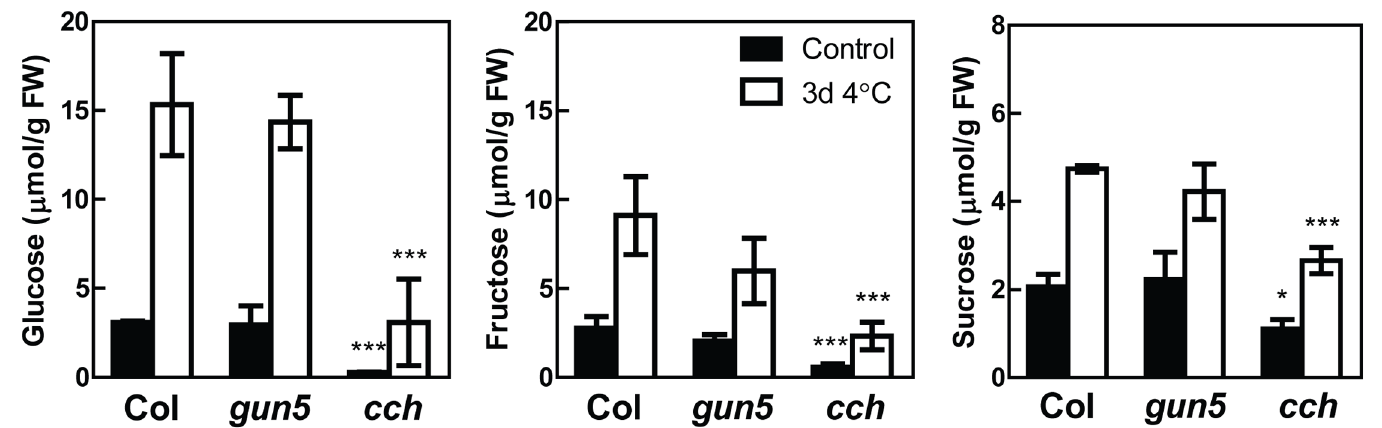
Fig 6. Sugar content in leafs of Col-0, gun5 and cch grown under control conditions and following exposure to low temperature. 5 week old plants were sampled and checked for their leaf sugar content in control and after 3 days of cold exposure. Samples were taken in the middle of the light period. No significant differences could be seen between Col-0 and gun5 plants (Student ’ s t-test). Between Col-0 and cch , significant differences could be seen for all sugars investigated, both in control conditions and following exposure to low temperature (Student ’ s t-test). p < 0.05 ( * ), p < 0.001 ( *** ).